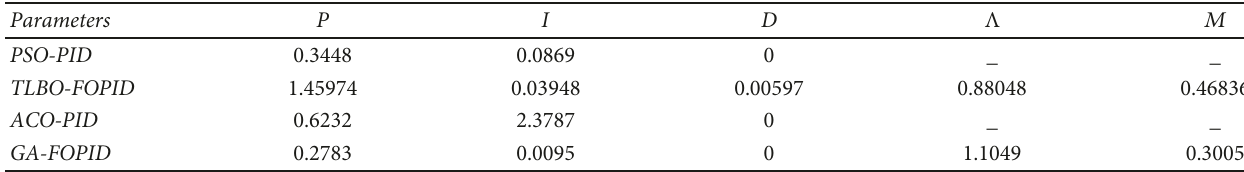
L (a) and the outer loop U pv (b). pv loop.